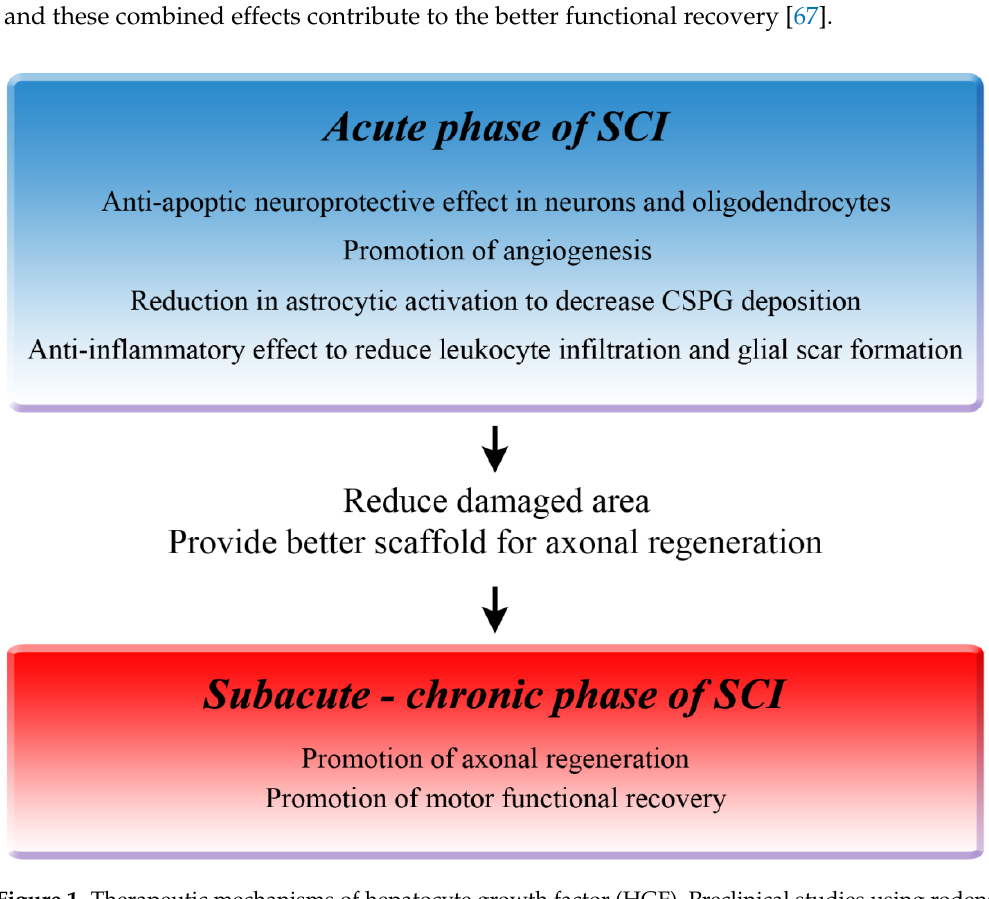
Figure 1. Therapeutic mechanisms of hepatocyte growth factor (HGF). Preclinical studies using rodent spinal cord injury (SCI) models revealed multiple therapeutic effects of HGF on the injured spinal cord that reduce the damaged area and promote functional recovery.